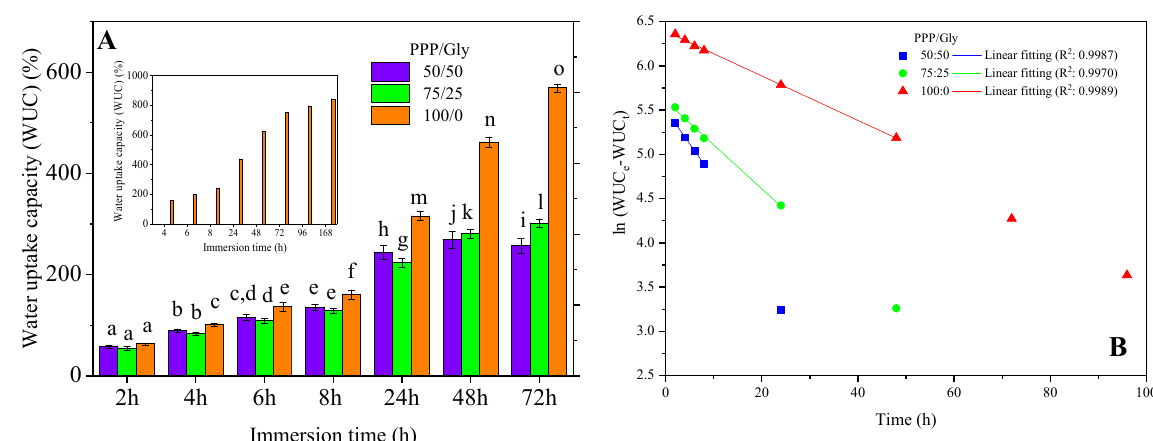
Figure 1. ( A ) Water uptake kinetics and ( B ) pseudo-first-order kinetic model for compression-molded porcine plasma protein (PPP)-based materials plasticized with glycerol (Gly) with different PPP/Gly ratios: 50/50, 75/25, and 100/0. Inset in Figure 1A shows the evolution of the 100/0 system over 168 h adsorption time.